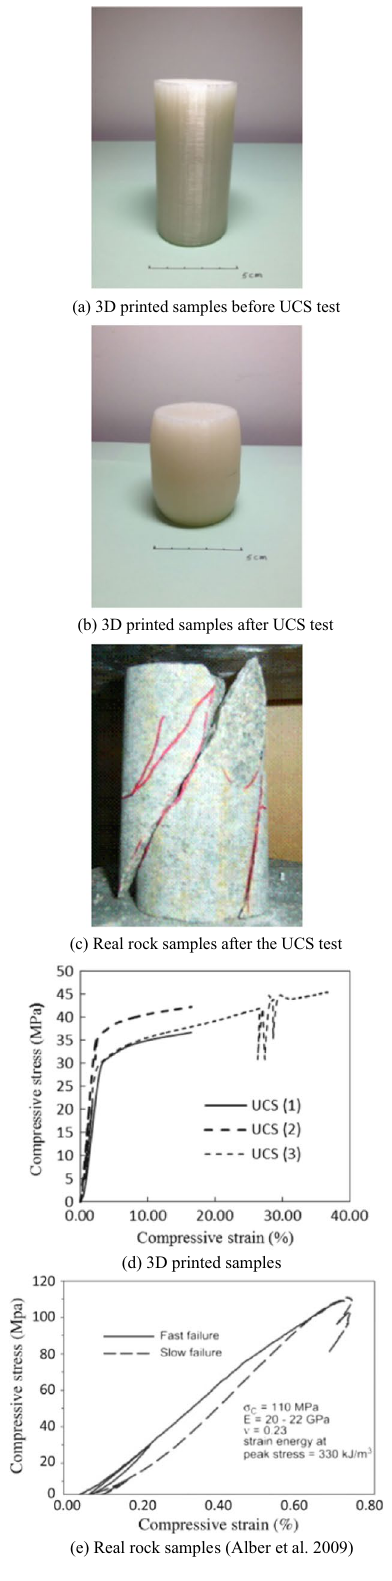
Fig. 5 Failure pattern and stress ‒ strain curve of 3D-printed samples and real rock samples in the UCS test (Jiang and Zhao